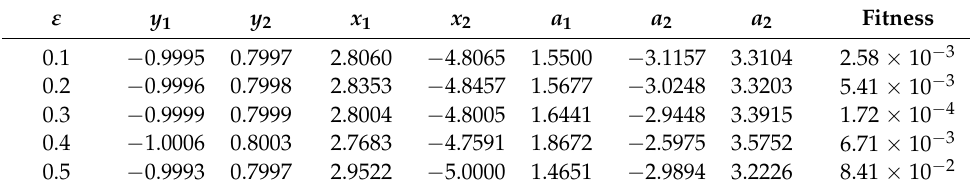
Table 5. Parameter estimates with level of estimation accuracy for ε =